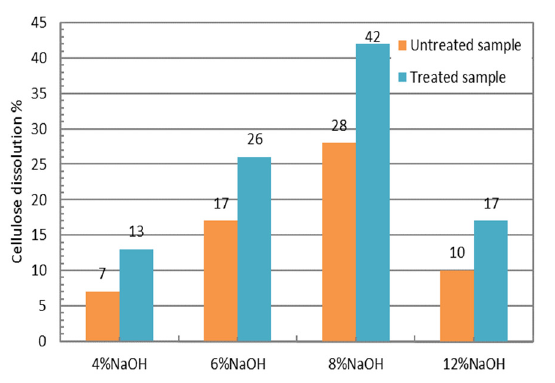
Fig. 6. Percentage of cellulose dissolution at different NaOH weight concentrations at temperature -20 ±2 o C.